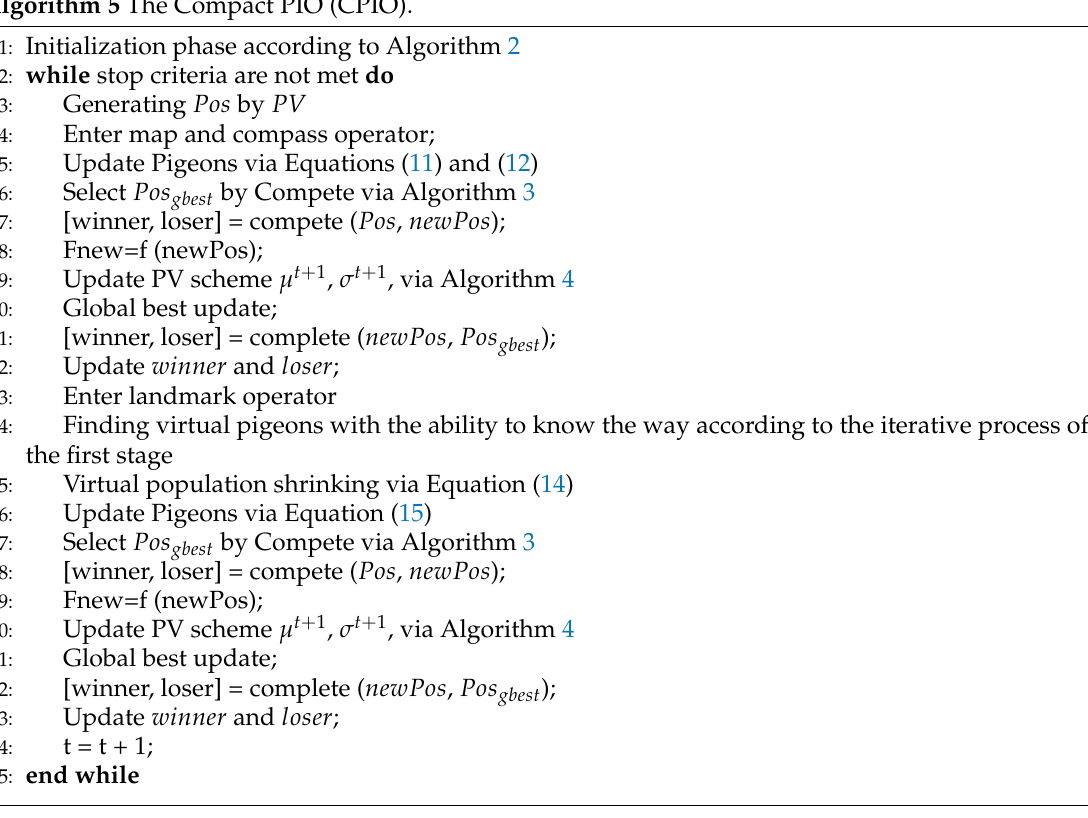
Algorithm 5 The Compact PIO (CPIO).